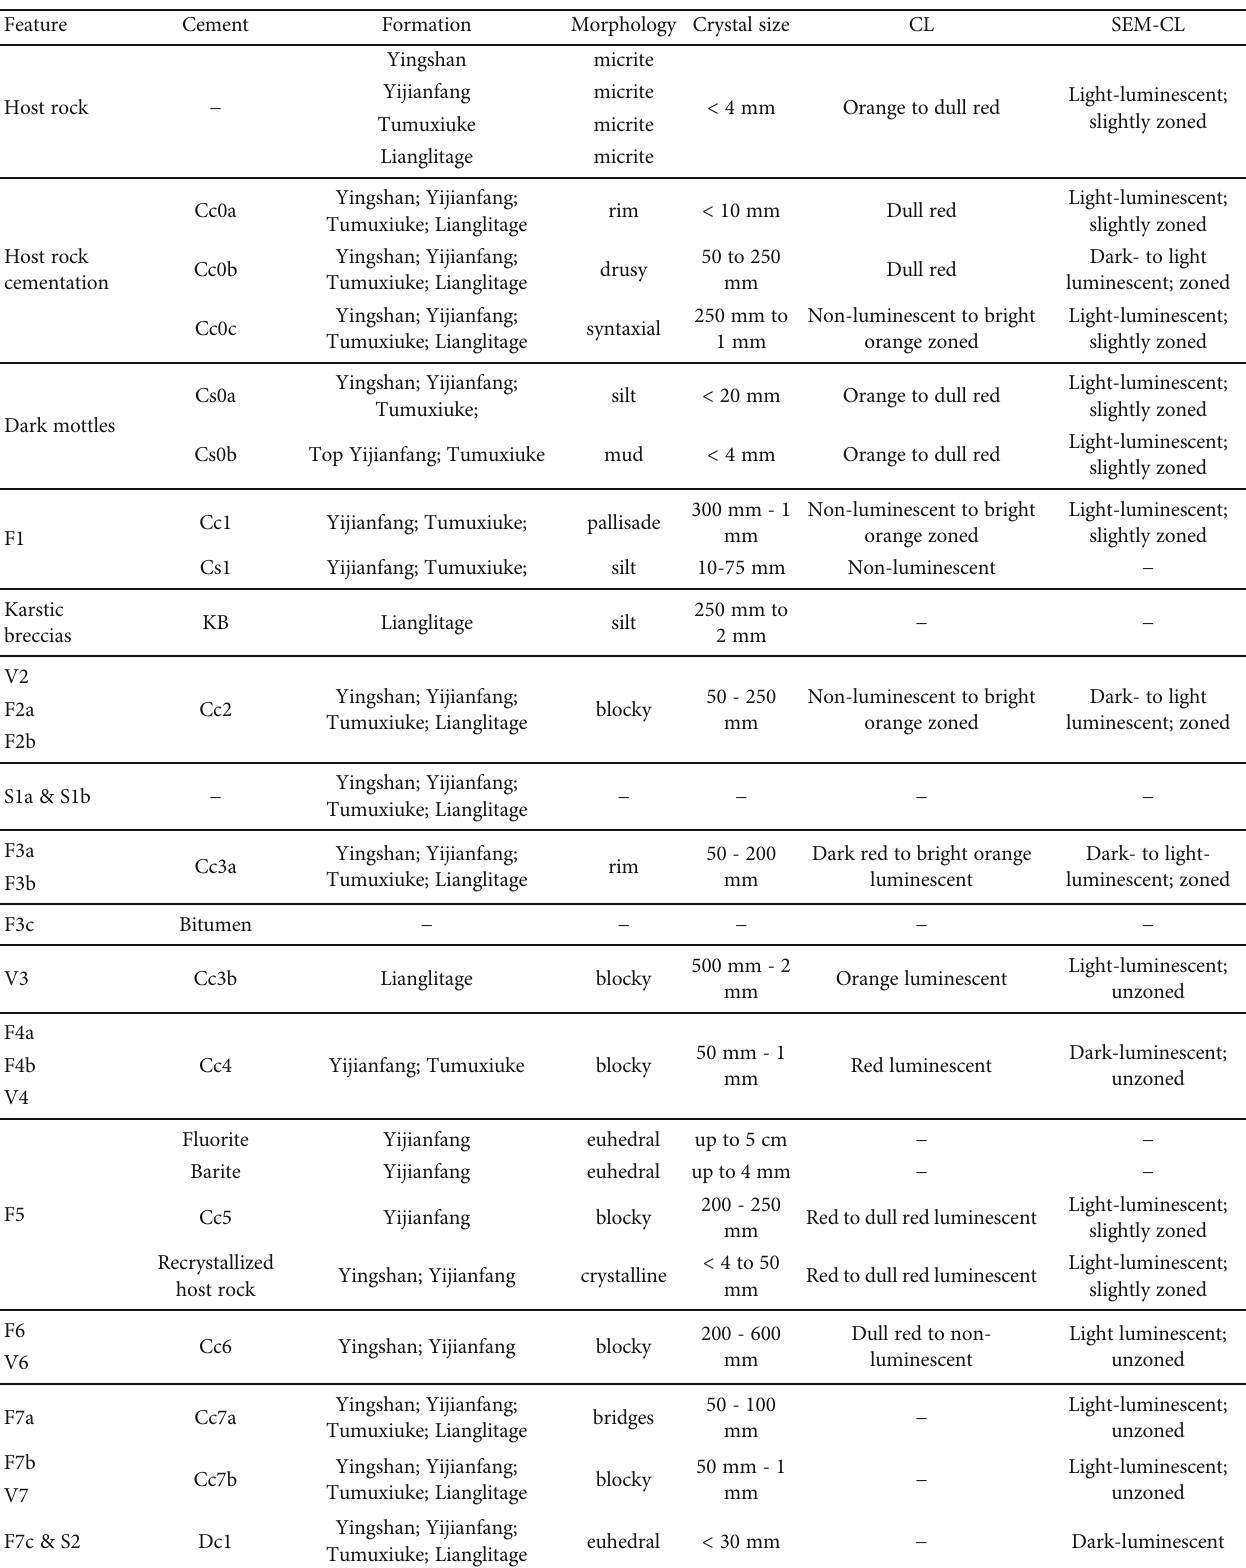
Table 1: Summary of petrographic characteristics of the main diagenetic features and cements shown in chronological order (paragenetic sequence). KB: matrix karstic breccia; F: fracture; V: dissolution vug; S: stylolite; Cc: calcite cement; Cs: calcite sediment; Dc: dolomite